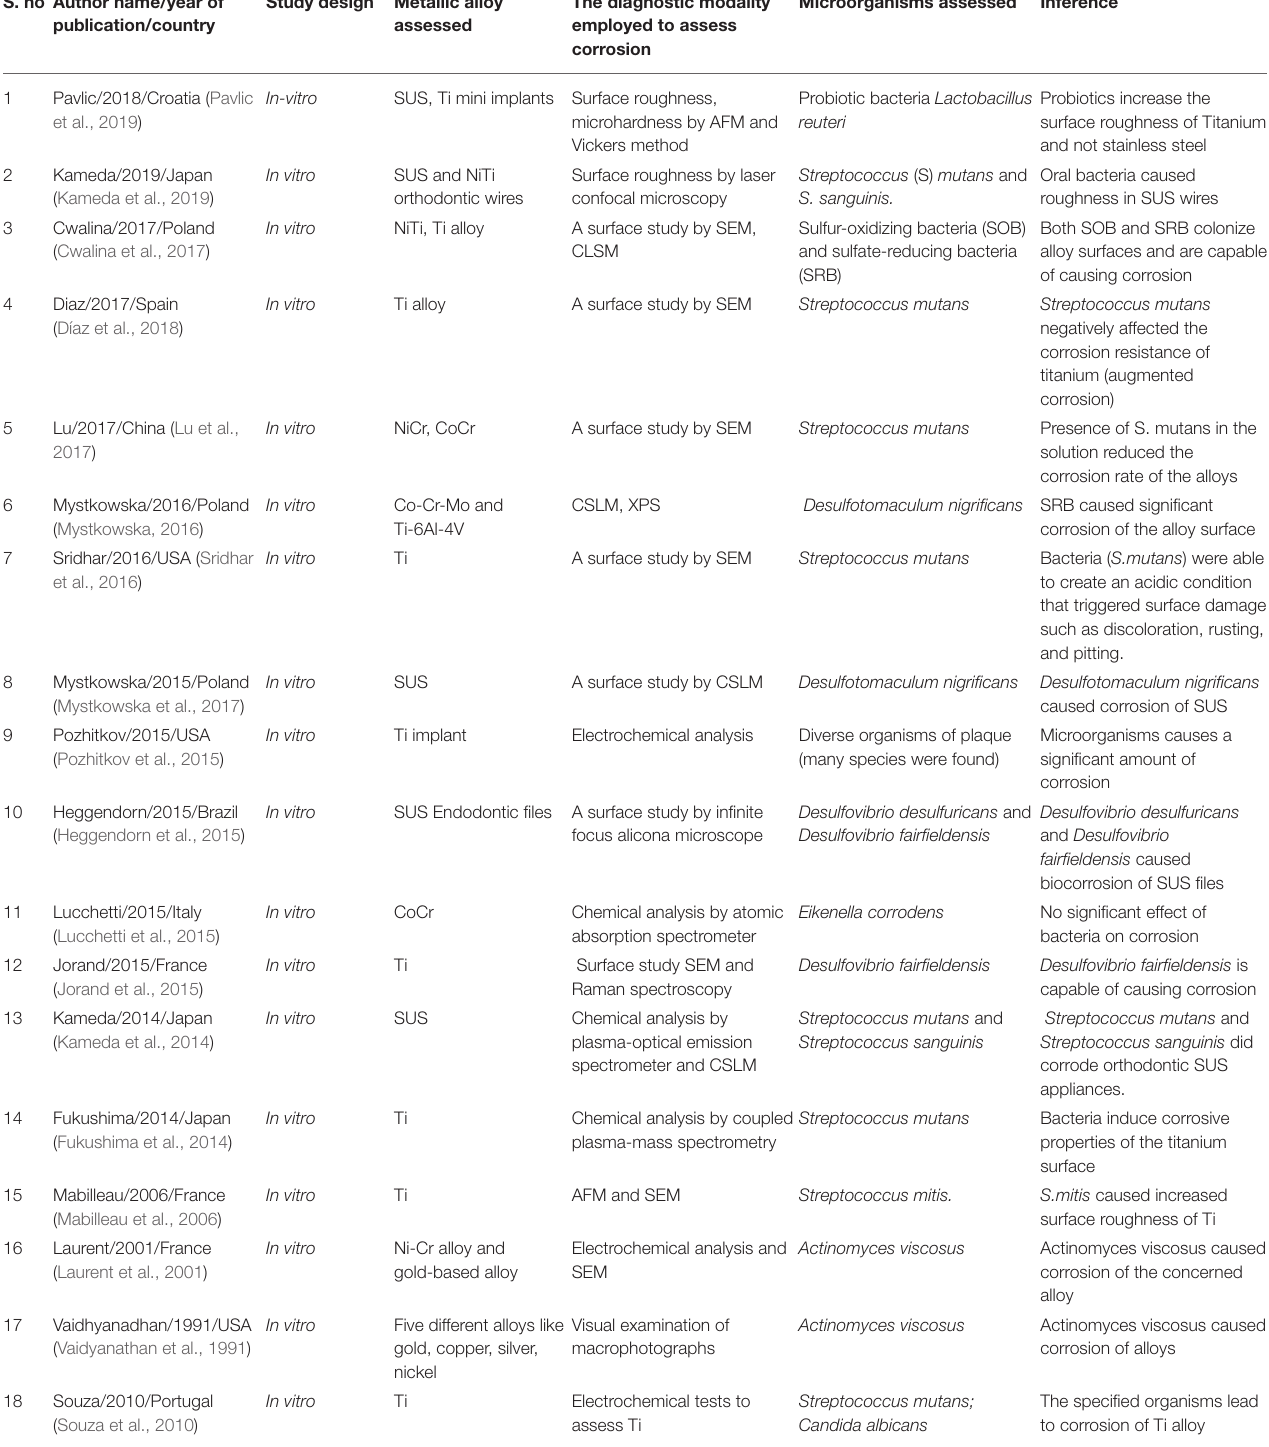
TABLE 1 | Data extracted from the studies included in the systematic